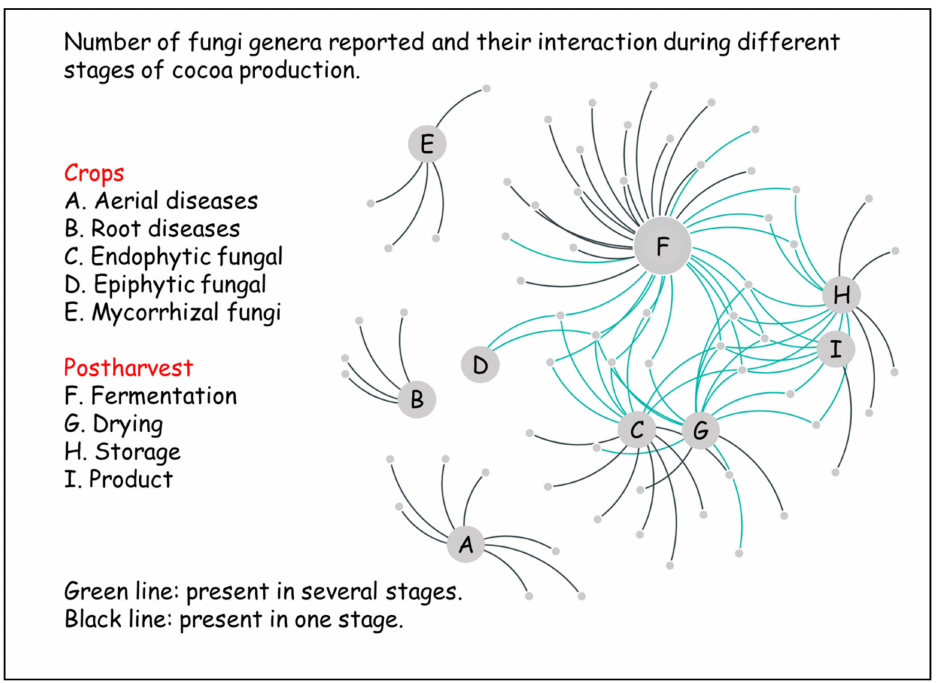
Figure 3. Main fungi interaction throughout the cocoa production